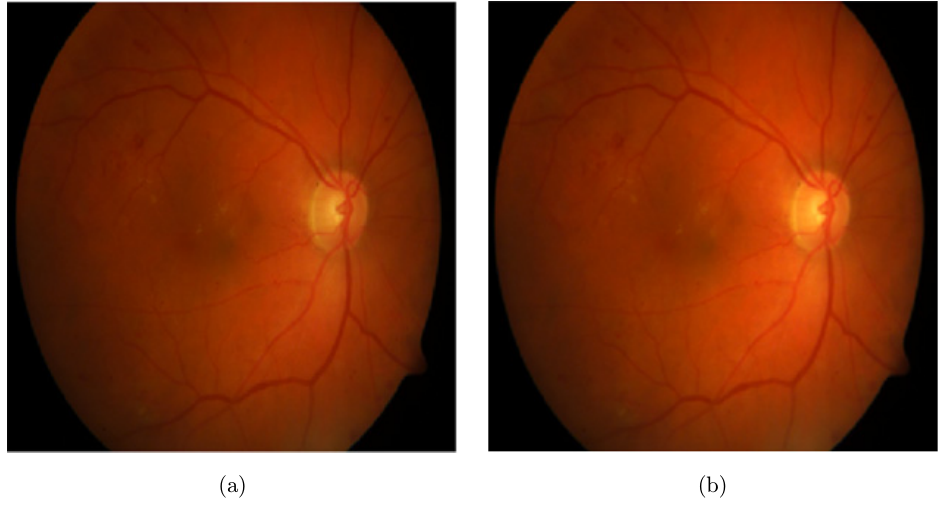
Fig. 3. (a) Input image and (b) preprocessed